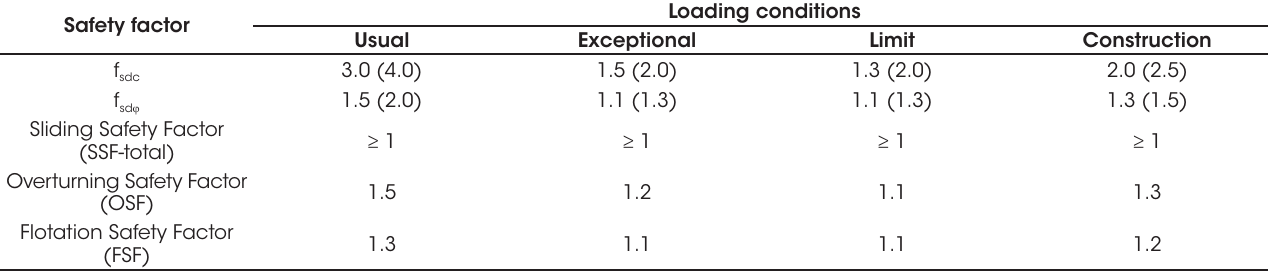
Minimum values of safety